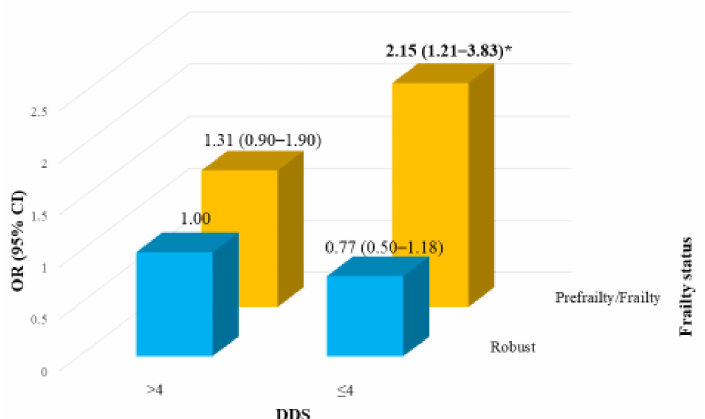
Figure 1. Joint odds ratios for cognitive impairment in frailty severity by dietary diversity score (DDS) (adjusted for age, sex, sampling stratum, education, body mass index, smoking, and general health); * p = 0.048 for interaction. OR, odds ratio; CI, confidence